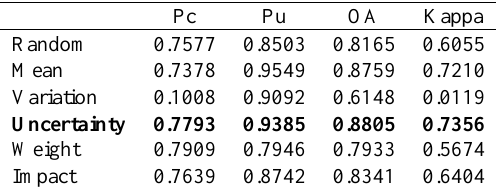
Table 3. The comparison of change detection results for different query strategies with active learning.